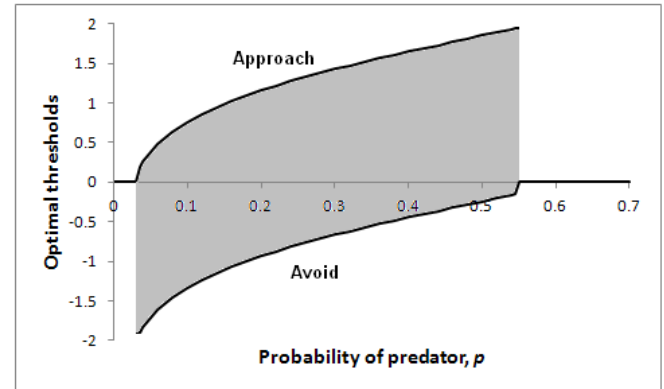
Figure 5. Optimal thresholds for approach (upper line) and avoidance (lower line) as a function of p in a particular